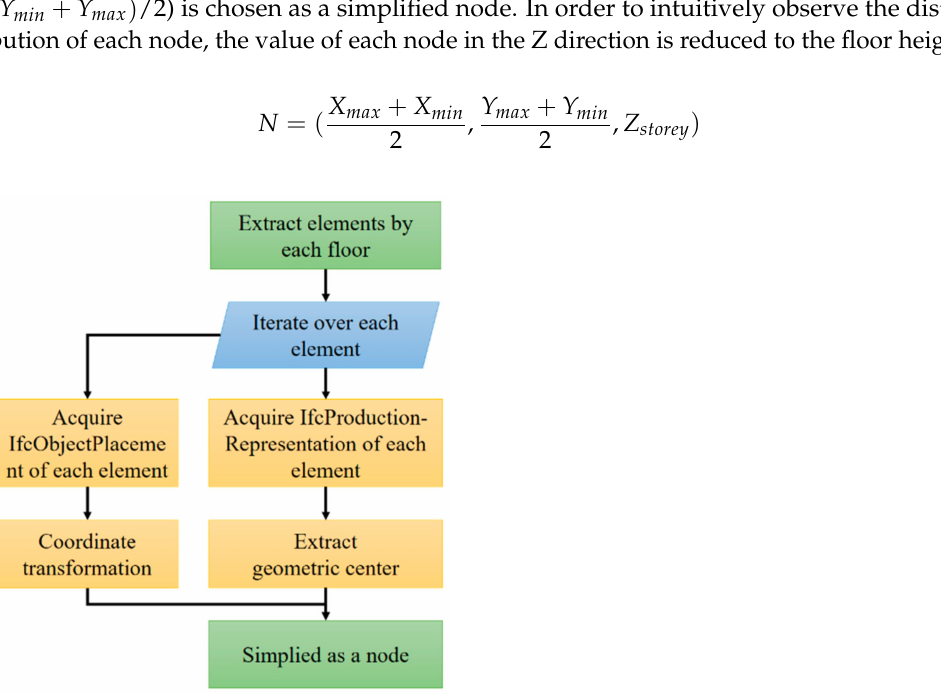
Figure 5. Flowchart of node